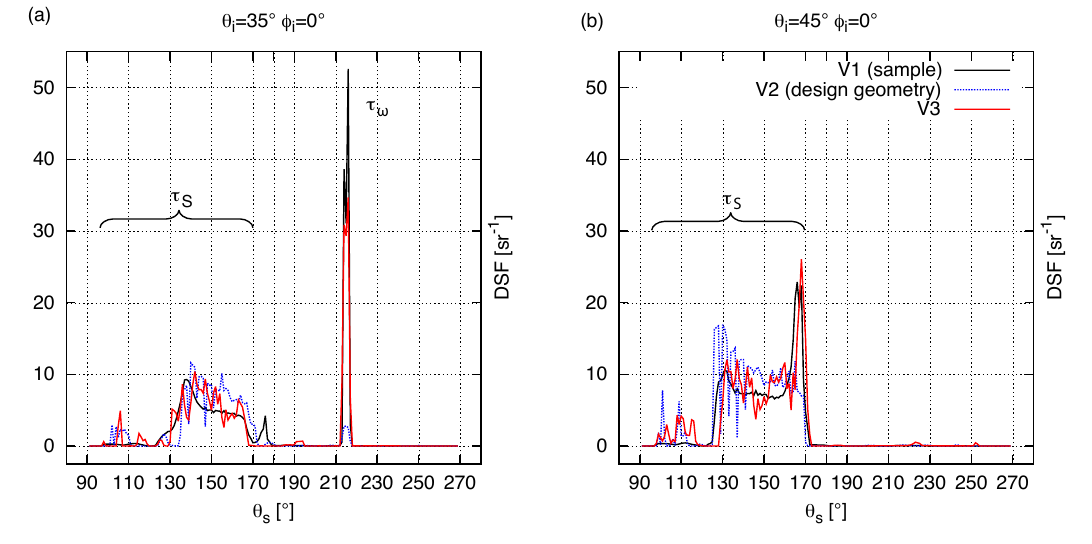
Figure 11. Linear section in the scattering plane: Measurements V1 (black), model V2 (design geometry, blue) and model V3 (red) for φ i = 0 ◦ and for θ i = 35 ◦ ( a ) and θ i = 45 ◦ ( b